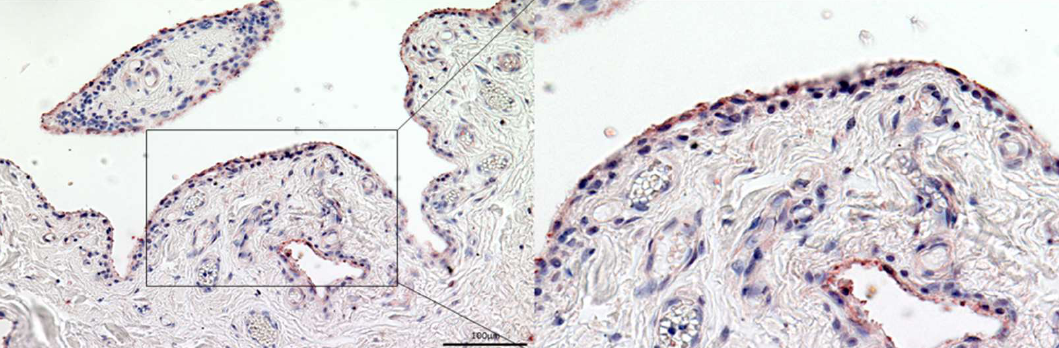
Figure 2. MLS and FLS react positively with an antibody against gelsolin. Section through the healthy synovial membrane. The antibody against gelsolin reacts intensively positive (red) with the MLS of the synovial membrane and also shows a weak positive reaction in the FLS and with individual cells in the subsynovial connective tissue. Counterstain: hemalum. Inset magnification ×10.